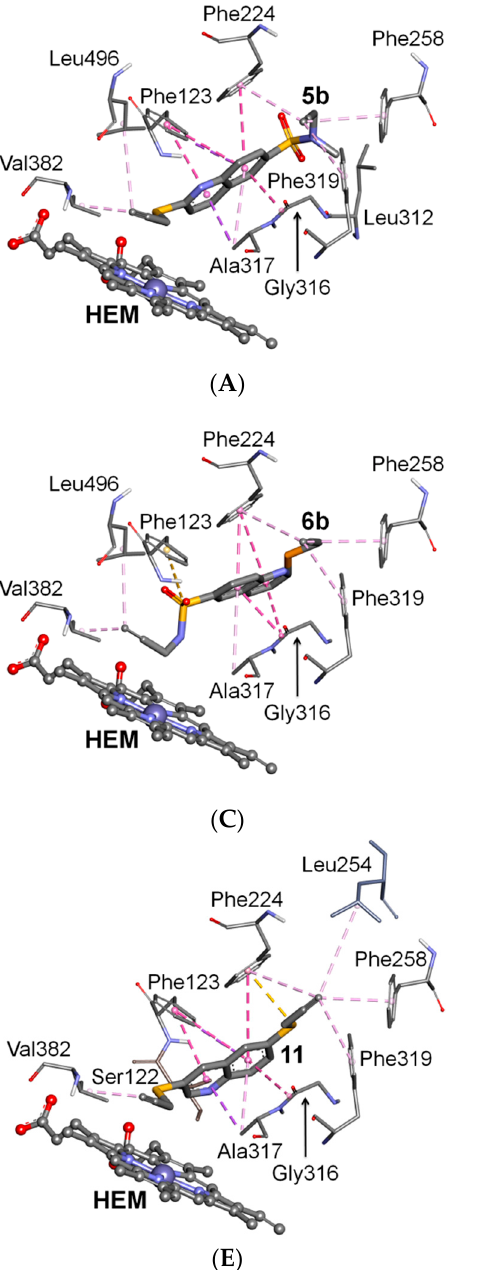
Figure 4. Binding site interactions between selected compounds and amino acid residues surrouning the active site of human CYPs. ( A ) 5b -CYP1A1; ( B ) 5b -CYP1B1; ( C ) 6b -CYP1A1; ( D ) 6b -CYP1B1; ( E ) 11 -CYP1A1; ( F ) 11 -CYP1B1. Hydrophobic ( π – π , π –alkyl, alkyl–alkyl) and miscellaneous (sulfur) interactions are rendered as magenta and yellow dashed lines, respectively.